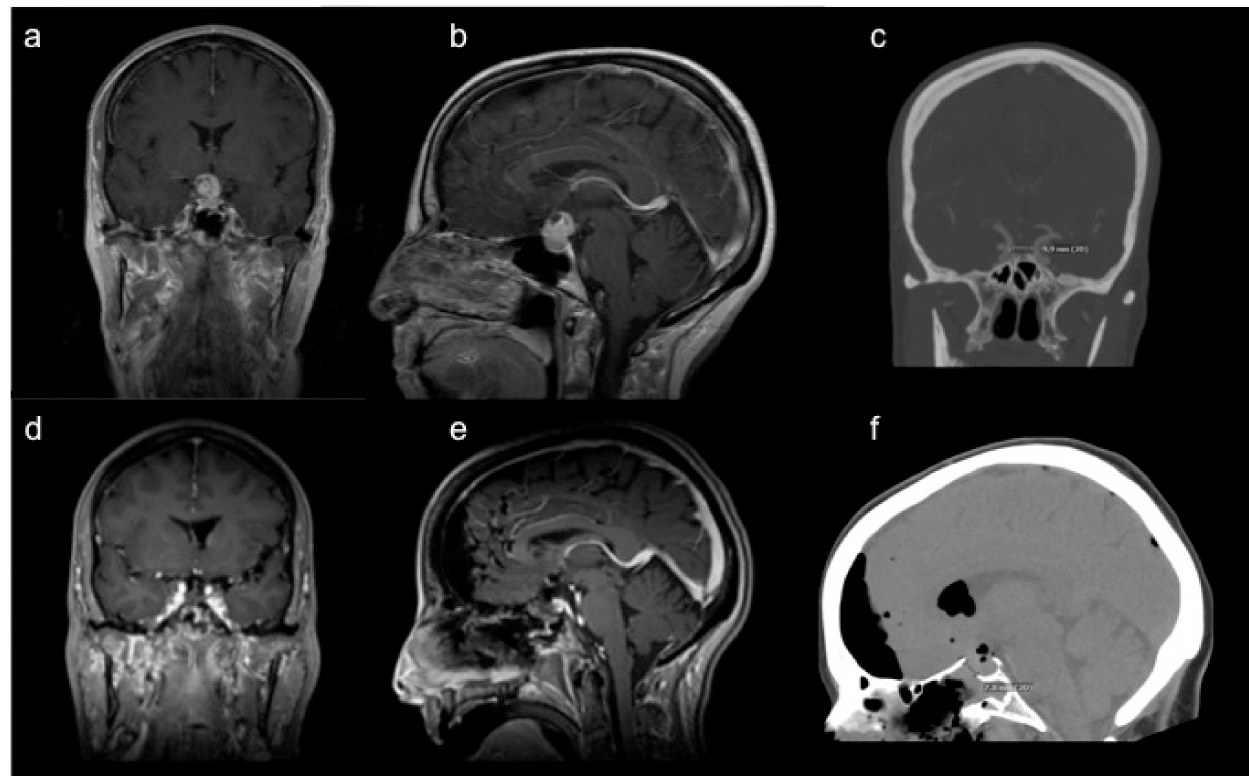
Figure 1. Relevant peri-operative imaging. A 67-year-old female presented with subjective decline in vision over several months and was diagnosed with bitemporal hemianopsia. Representative ( a ) coronal and ( b ) sagittal T1-weighted post-contrast magnetic resonance image (MRI) revealed a heterogeneously enhancing 1.7 cm sellar/suprasellar mass, consistent with a diagnosis of cranio- pharyngioma. ( c ) Pre-operative coronal computed tomography angiography (CTA) demonstrated an approximate 1 cm inter-carotid distance, relevant for surgical planning. Representative post- operative ( d ) coronal and ( e ) sagittal T1-weighted post-contrast MRI showed gross total resection through a ( f ) minimally invasive sub-centimeter craniotomy via an endoscopic endonasal transphe- noidal approach, as shown on sagittal